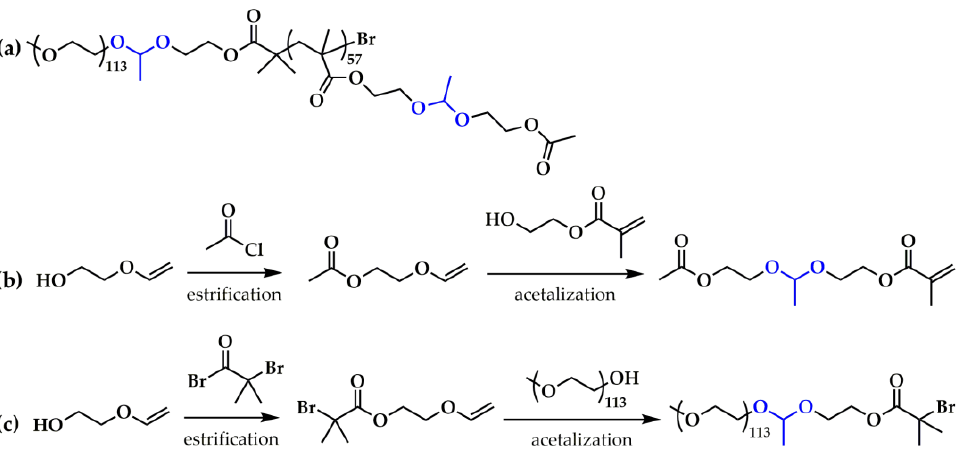
Figure 6. ( a ) Structure of a dual location acid-cleavable amphiphilic LBCP containing pH-labile acetal groups, as well as synthetic pathways, resulting in the preparation of ( b ) ATRP monomer and ( c ) ATRP macroinitiator used for its synthesis